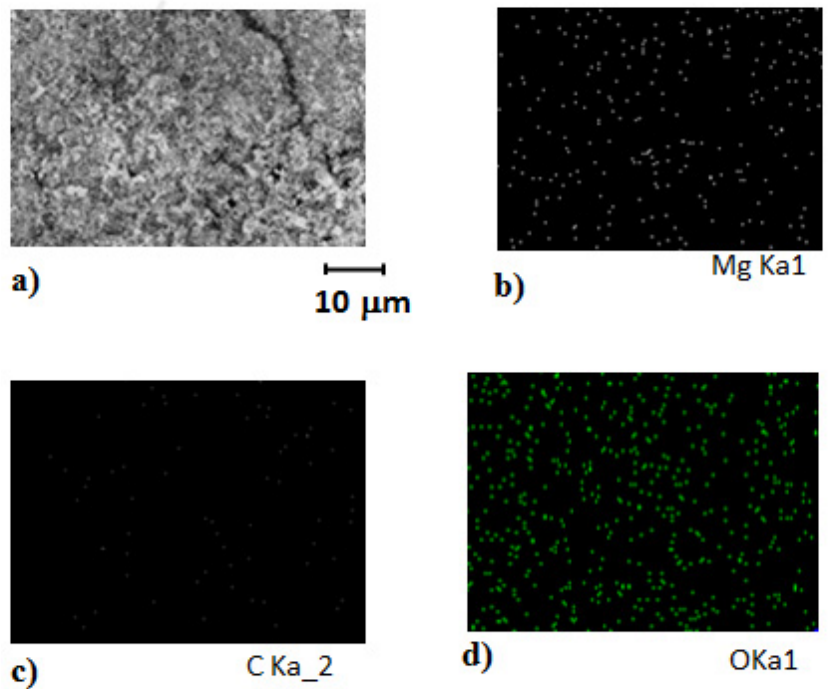
Figure 2. Internal morphology and structural properties of a MgOx electrode over a conductive polymeric base by ( a ) SEM, ( b ) EDX for Magnesium, ( c ) for Carbon, ( d ) for Oxygen after hot